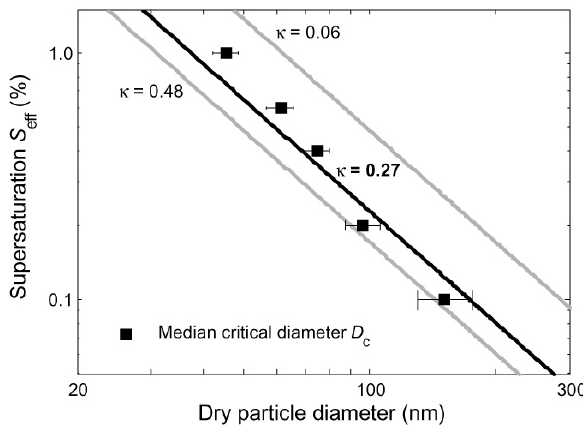
Fig. 4. A contour plot frequency distribution of the critical diame- ters calculated by two methods. Each grid cell is 1nm × 1nm. In- cluded in the figure is the 1:1 line (white line).